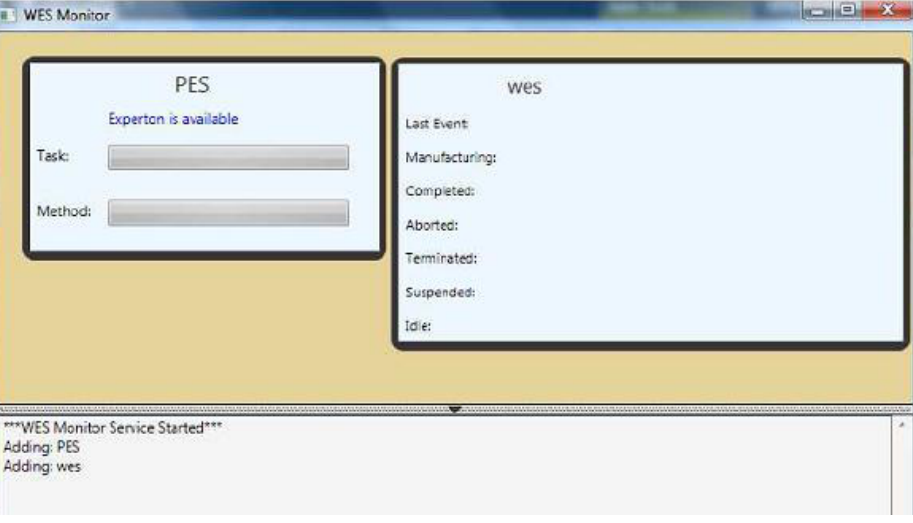
Figure 5. Monitoring Service